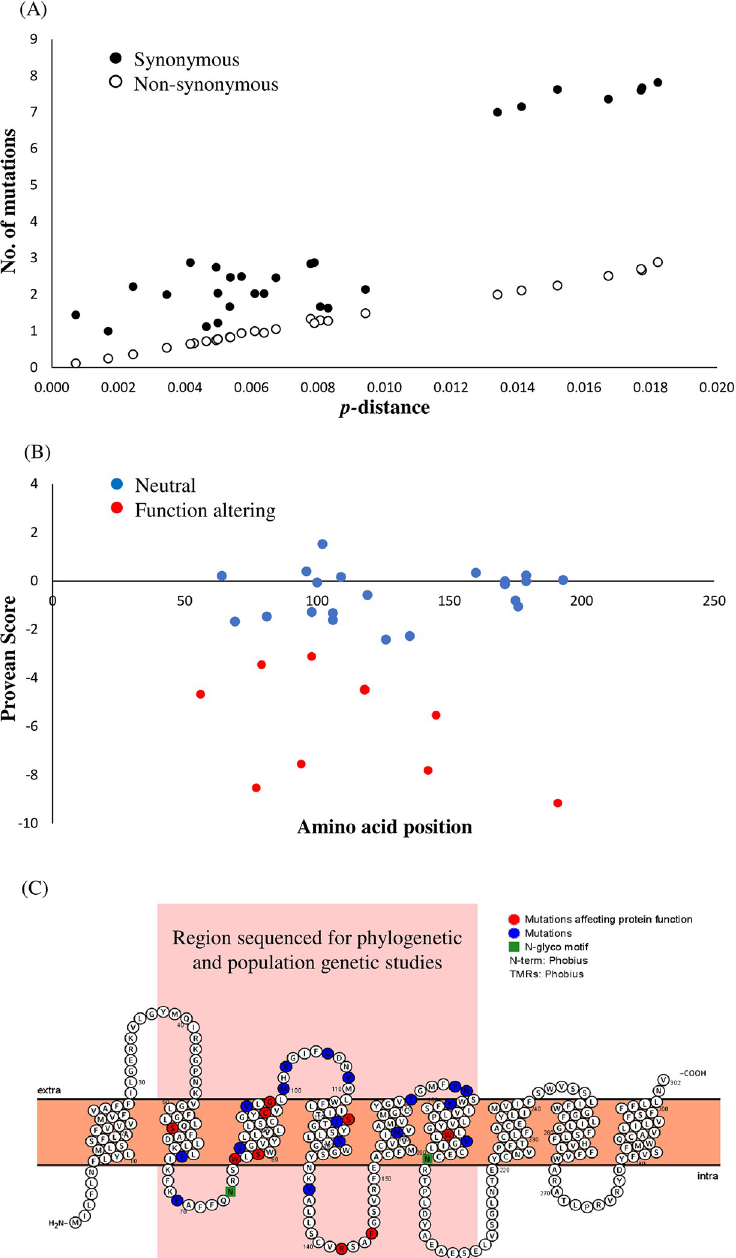
Fig 5. Detection of selection and the impact of amino acid replacements on Echinostoma revolutum ( s . s .) nad 1. ( A) Contribution of synonymous and non-synonymous mutations to divergence ( p -distance) between sequences within the Eurasian alignment based on pairwise differences between individual sequences within an alignment. (B) Provean analyses showing the distribution of amino acid replacements with all those with a score � -2.5 indicating a potential function altering change. (C) Protter 2D model of the nad 1 protein illustrating the position and domains within which amnio acid replacements are occurring.